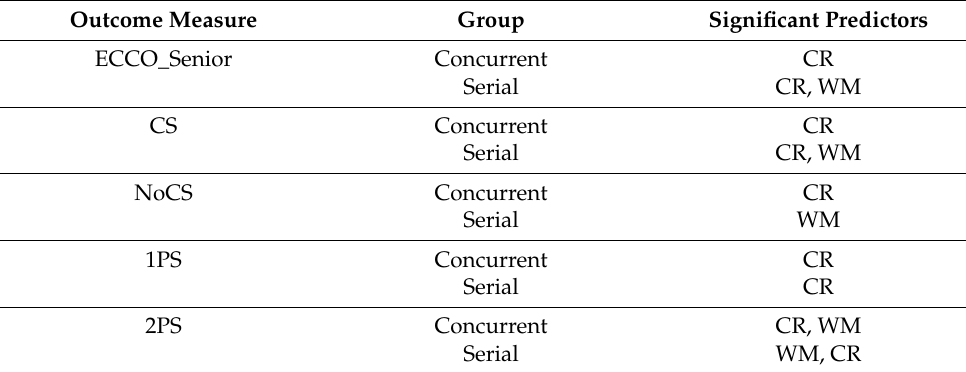
Table 9. Summary of results from the regression